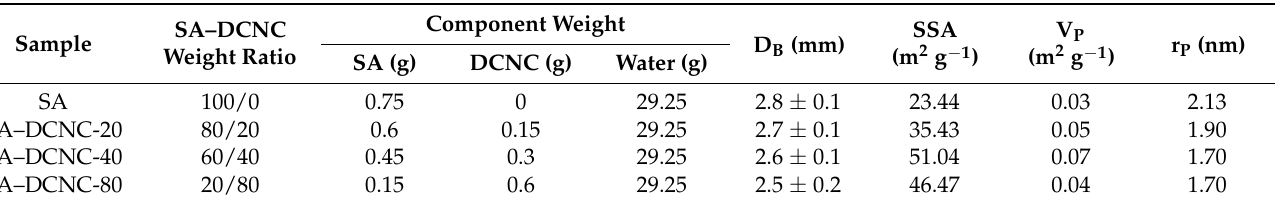
Table 2. Composition, bead diameter (D B ), BET specific surface area (SSA), pore volume (V P ), and pore radius (r P ) of various SA–DCNC